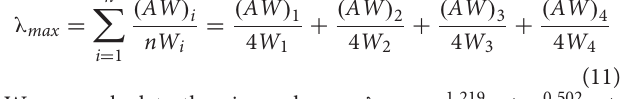
FIGURE 5 | The calculation process of